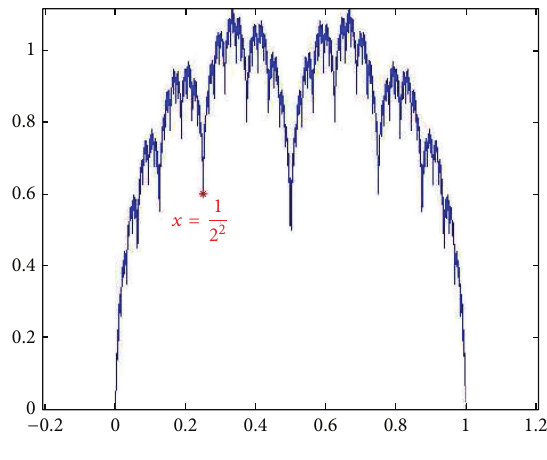
Figure 1: Overview of the